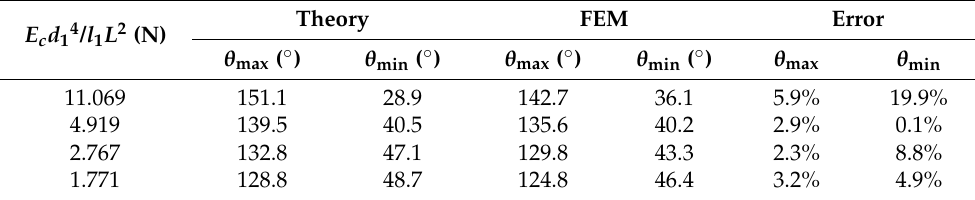
Table 9. Comparison of the theoretical and numerical results for different CFRP